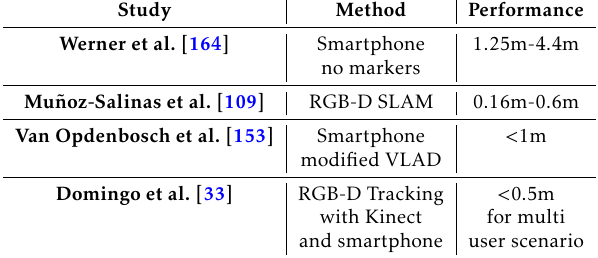
Table 1. Table of recent camera-based systems with their method and performance.